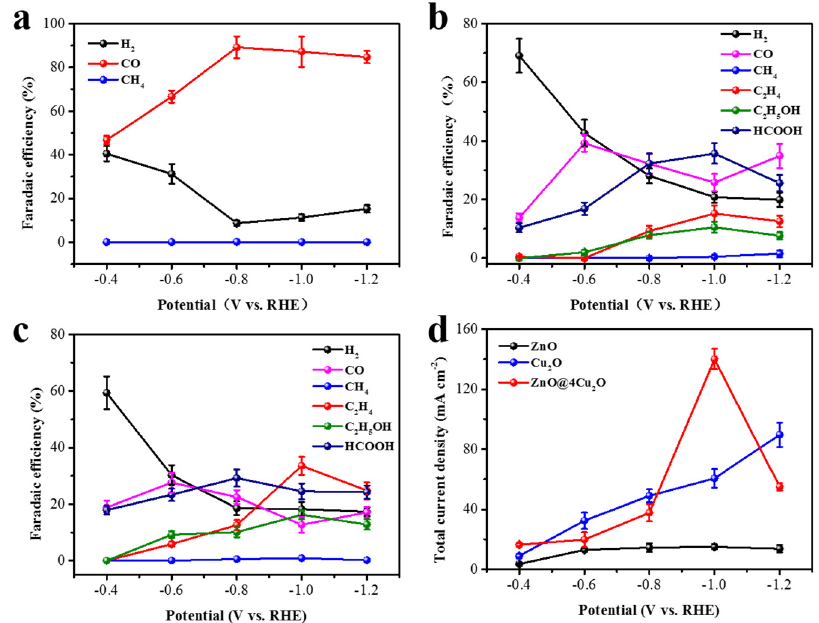
Figure 5. Faradaic efficiency of products on different catalysts ( a ) ZnO-400, ( b ) Cu 2 O, and ( c ) ZnO@4Cu 2 O. ( d ) The total current density of products on different catalysts.